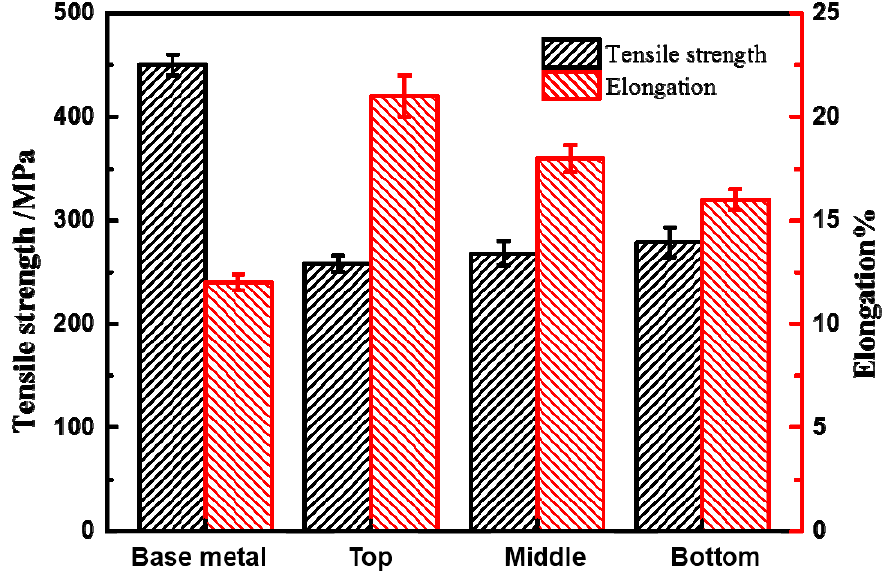
Figure 10. Transverse tensile properties of weld nugget in FSW CuCrZr alloy at room-temperature.